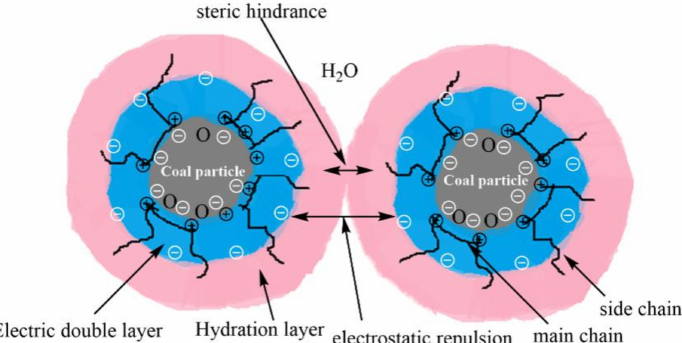
Figure 7. Schematic illustration of the adsorption and dispersion mechanism of S-CSHE. The middle-rank coal of the Zhundong area of Xinjiang has contained pore struc- ture, high internal water content, and oxygen-containing side-chain functional